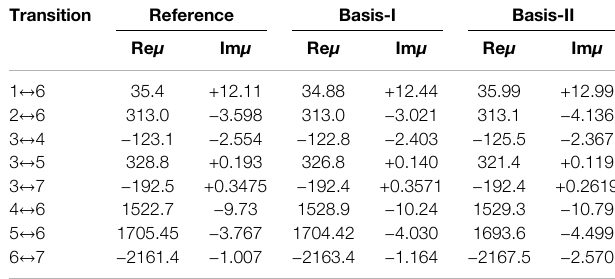
FIGURE5| TheRVPcomplexenergies(Re E + i Im E )ofthedoublyexcited Feshbach He** states contrasted with the exact values, in mHartree. These energies are also presented in Table 1 . The RVP energies are in remarkable agreement with the exact ones. Reprinted (adapted) with permission Ref. [50]. Copyright (2019) American Chemical Society.